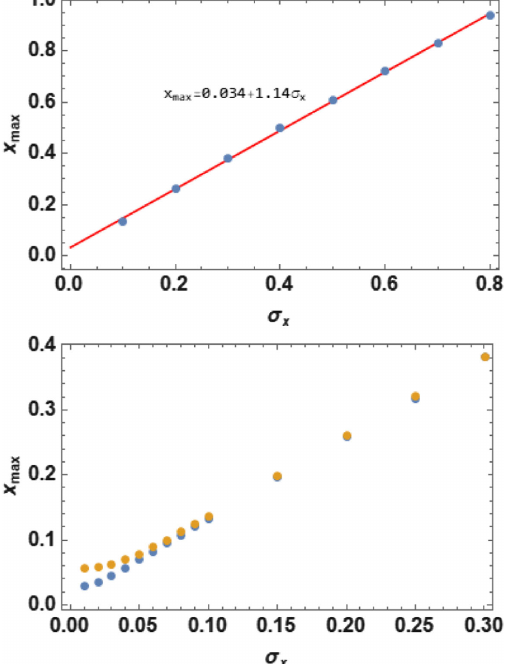
FIG. 12. Dependency of the maximums position x m on the beam size σ x . Bottom one represents smaller beam size depend- ence. Lens aperture: x m ¼ y m ¼ 50 (orange points); x m ¼ y m ¼ 100 (blue